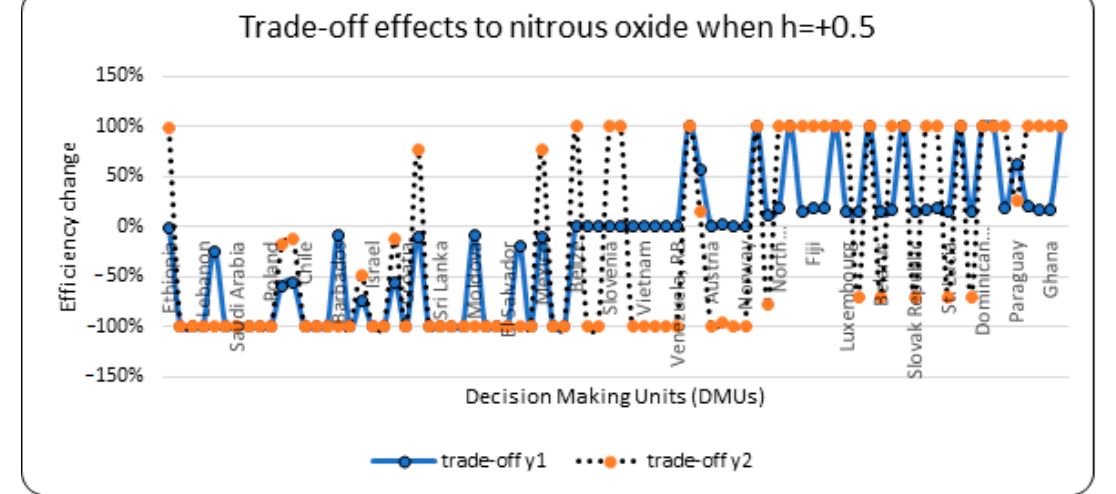
Table 7. Trade-off effects on the nitrous oxide ( 𝑧 (cid:2870)(cid:3029) ) when ℎ = + 0.5 and 𝑑 = (1, 1).